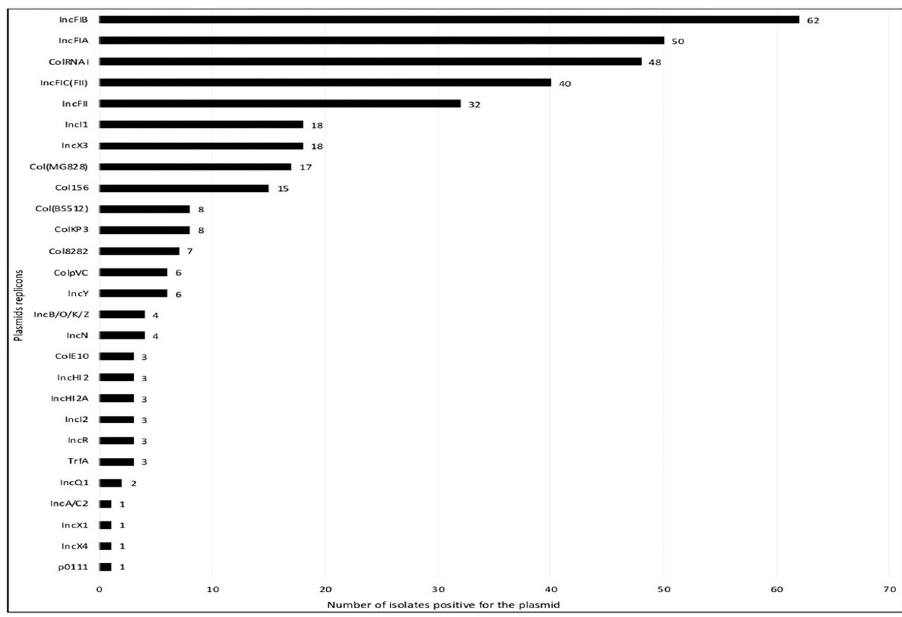
Fig 9. Distribution of plasmids replicons.